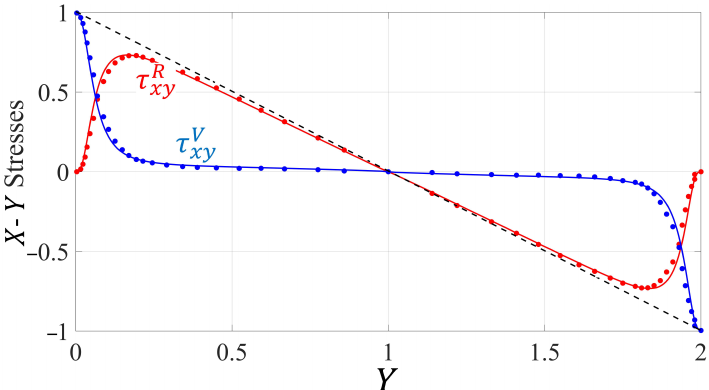
Figure 10. Distributions of X − Y shear stresses over the full height of the smooth channel: (blue) vis- cous stress; (red) Reynolds stress; (black) total stress. The present results are shown with solid/dashed lines, while reference results by Kim et al. [44] are plotted with filled